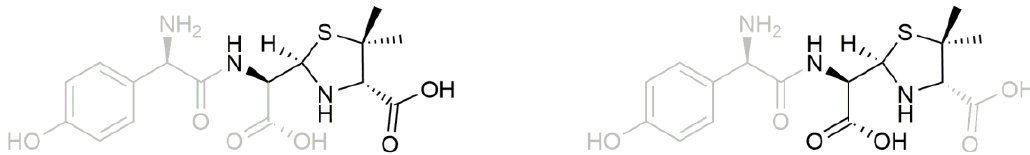
Figure 14. Two possible positions of fragment m / z 323 ions in amoxicilloic acid.